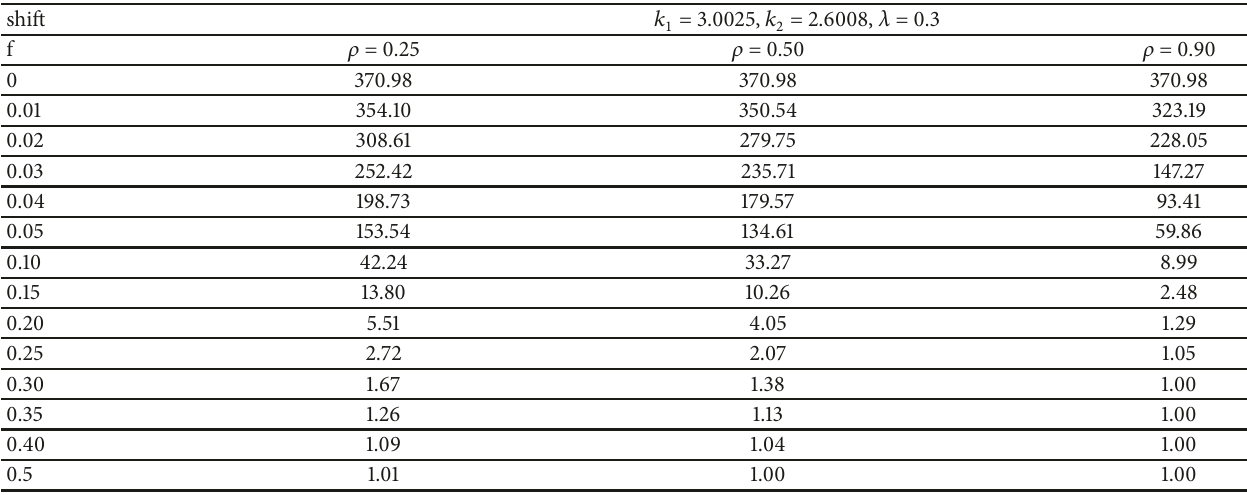
Table 6: ARLs for proposed repetitive EWMA-RSS control chart using Bahl and Tuteja (1991) exponential ratio-type estimator, when 𝑟 𝑜 is 370.